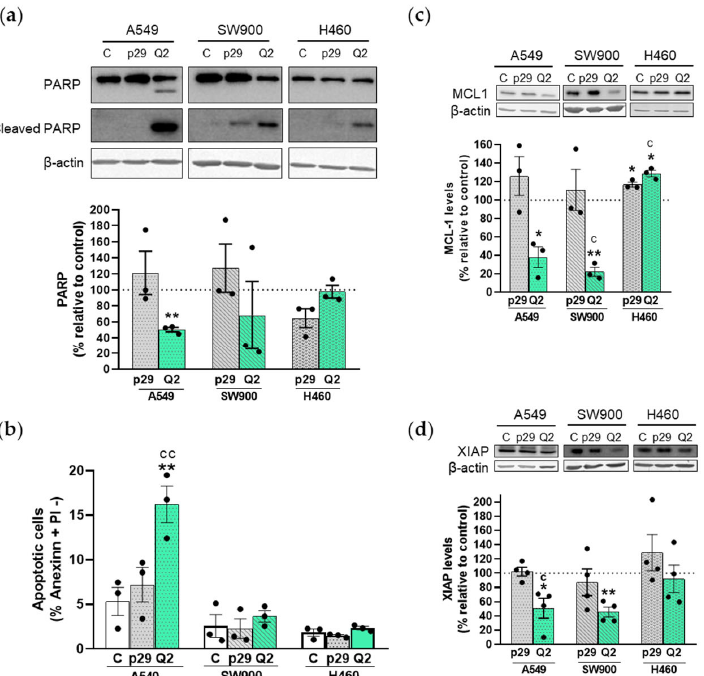
Figure 2. Apoptotic activity of apMNKQ2 on NSCLC cells. ( a ) On the top, lysates (20 μ g) were resolved in 10% SDS-PAGE gels for PARP and cleaved PARP. On the bottom, densitometry analyses of total PARP in the three cell lines. Data were normalized to respective β -actin bands and expressed as the percentage relative to control (C) cells. The graphs represent the mean ± SEM of 3 independent experiments. ( b ) Quantification of early apoptotic cells by Annexin-V staining. The bars represent the mean percentage of Annexin-V positive and PI negative cells ± SEM of 3 independent experiments. ( c , d ) Densitometry analyses of XIAP and MCL-1. Both were normalized to respective β -actin bands and expressed as the percentage relative to control (C) cells. The graphs represent the mean ± SEM of 3–4 independent experiments. Lysates (20 µ g) were resolved in 12% gels for XIAP and MCL-1 and western blot analysis was carried out using specific antibodies (see Supplementary Table S1). A representative blot is shown on the top of each graph. * p < 0.05 and ** p < 0.01 relative to control cells; c p < 0.05 and cc p < 0.01 relative to p29 control. Control is shown as C, p29 is the unspecific aptamer used as a negative control, and apMNKQ2 is shown as Q2. Each solid black circle represents one individual